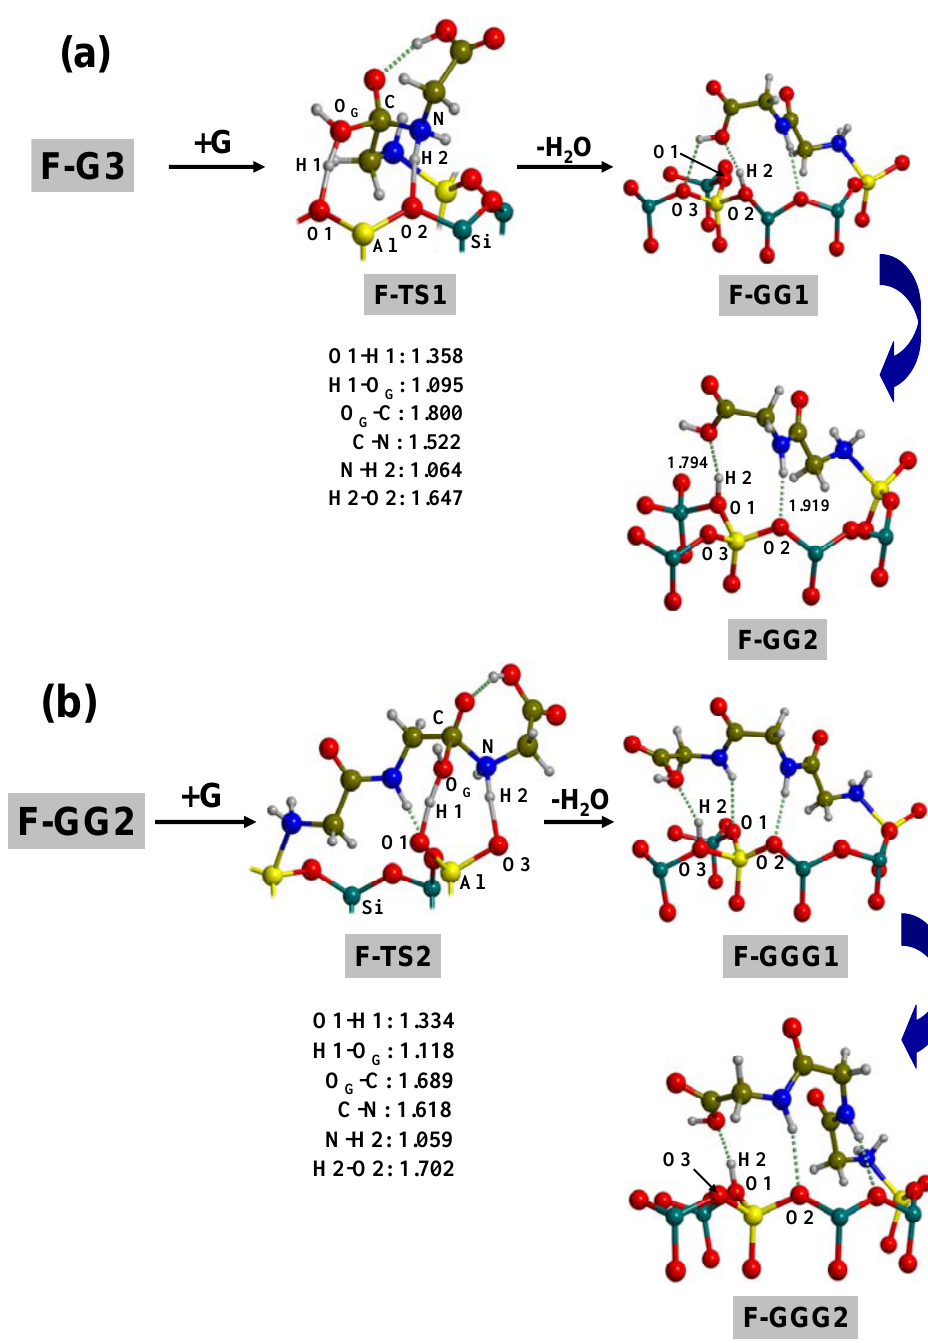
Figure 3. (a) ONIOM2-optimized geometries for the condensation of glycine adsorbed onto sanidine feldspar surface ( F-G3 ) with another incoming glycine ( G ) resulting in a dipeptide attached to the surface ( F-GG1 and F-GG2 ). (b) Same as section a) starting from F-GG2 to give tripeptides attached to the surface ( F-GGG1 and F-GGG2 ). Distances in